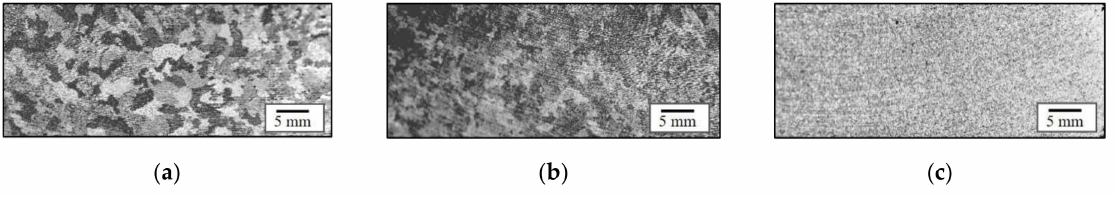
Figure 6. Macrostructure of hypoeutectic alloy with copper, Alloy 1: ( a ) untreated; ( b ) standard flux; ( c ) complex flux.